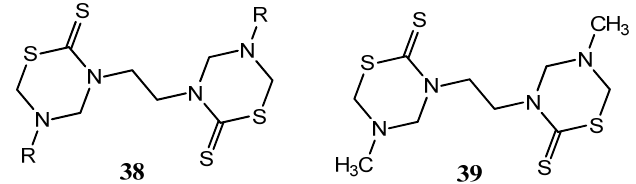
Figure 14. 3,3'-ethylenebis(5-alkyl)-THTTs ( 37 ) tested as antifungal